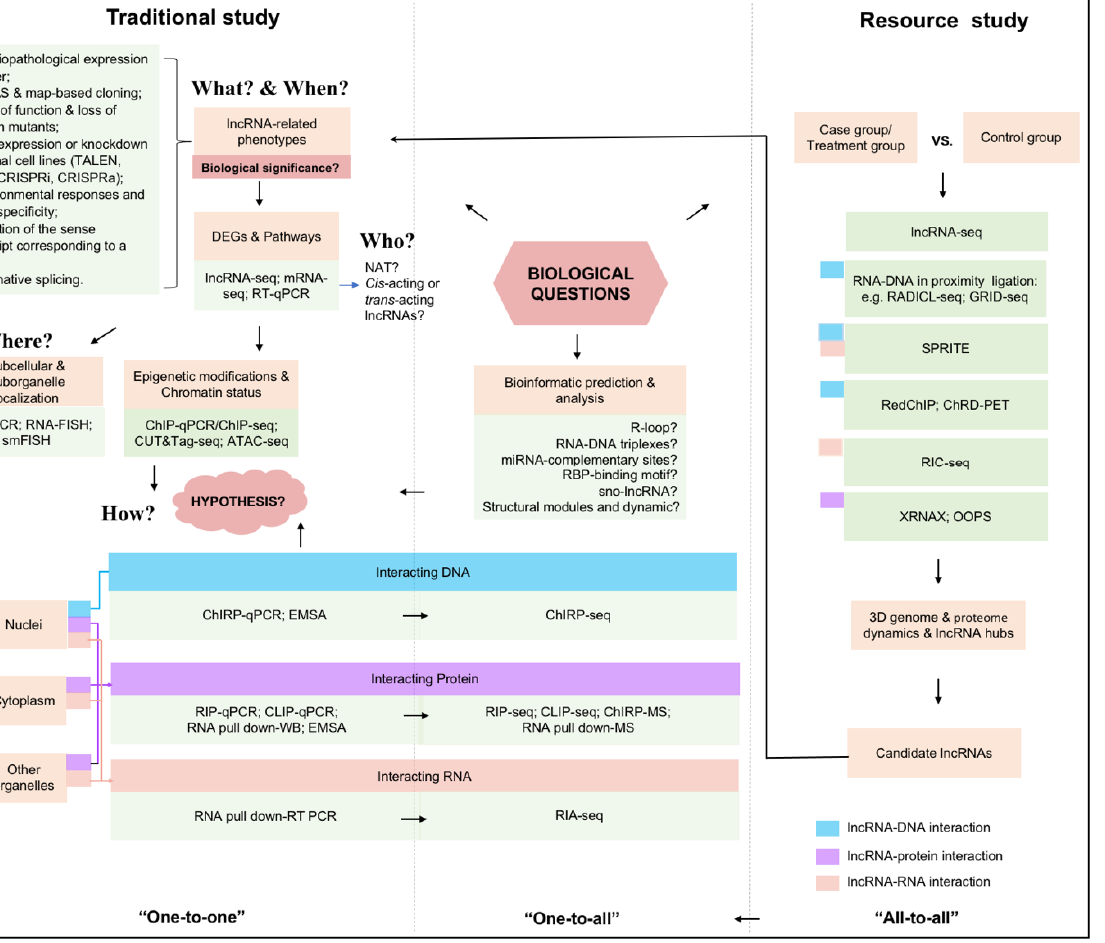
qPCR, RT-qPCR or WB), e.g., RIP-qPCR, RNA pulldown-WB; ‘one-to-all’: approaches to determine